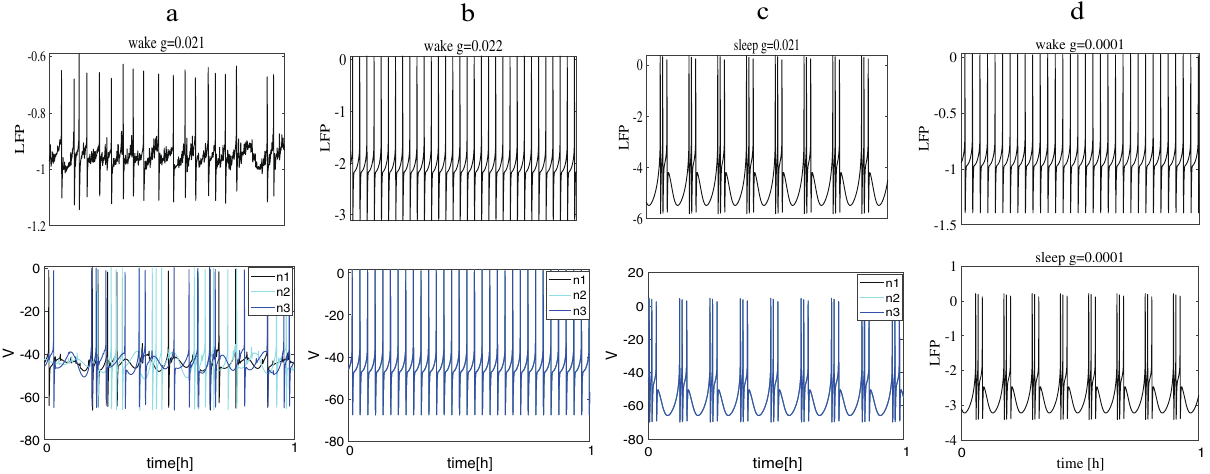
Figure 4. The LFP of two random networks and membrane potential V of neurons. ( a )–( c ) The network structure is each neuron in the lattice network randomly add 1 long-range connections. (d) The number of random long-range connections is 10. ( a ) and ( b ) The LFP plots and corresponding membrane potential plots at g = 0.021 and g = 0.022 which corresponds to Fig. 3b (modena and bright orange) during wake. ( c ) The LFP plots and corresponding membrane potential plots at g = 0.021 during sleep. ( d ) The LFP plots for g = 0.0001 during sleep (bottom) and wake